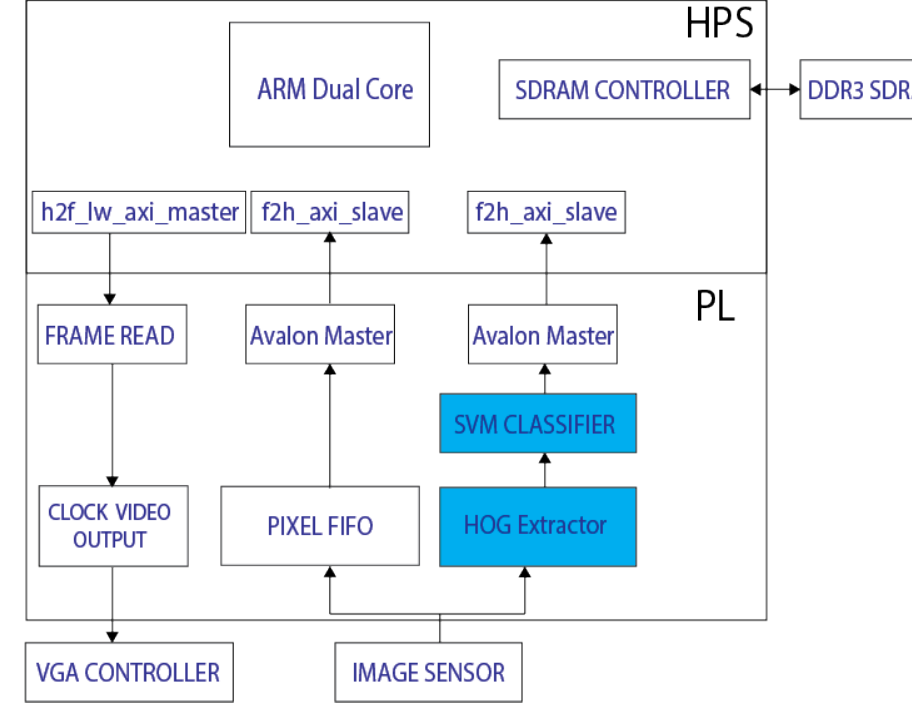
Figure 2. System